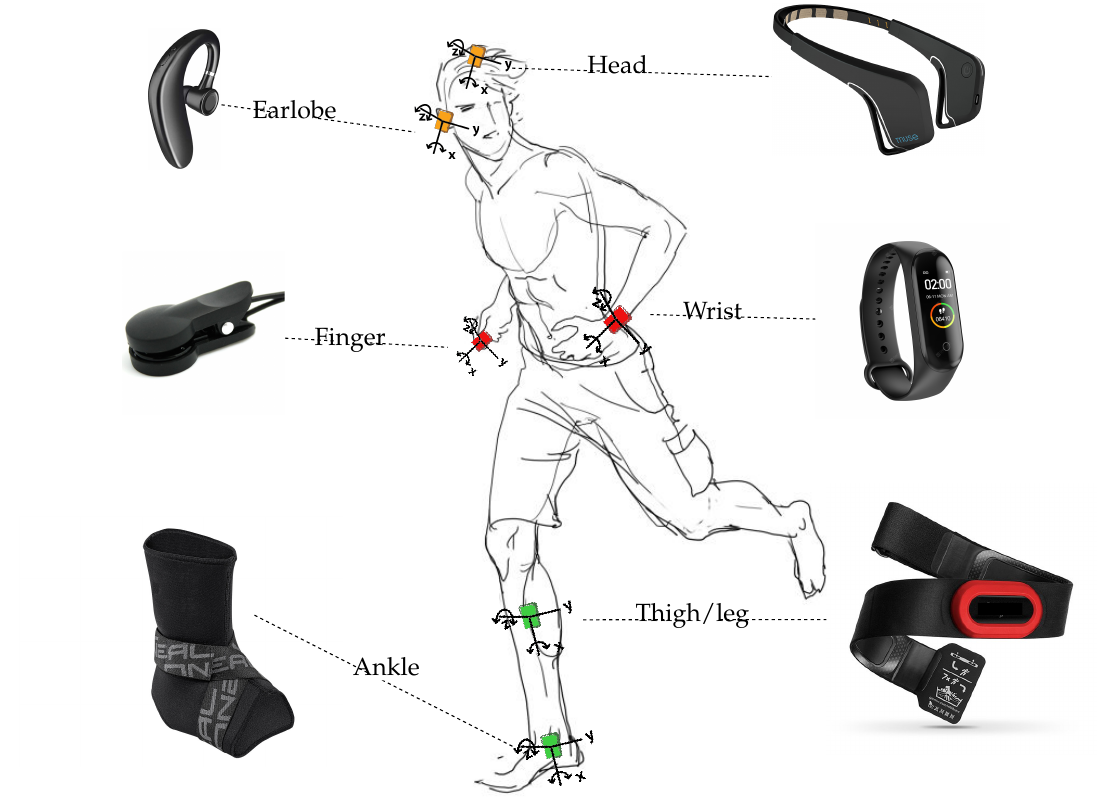
Figure 1. Examples of concrete wearable devices, along with their typical on-body location, can be